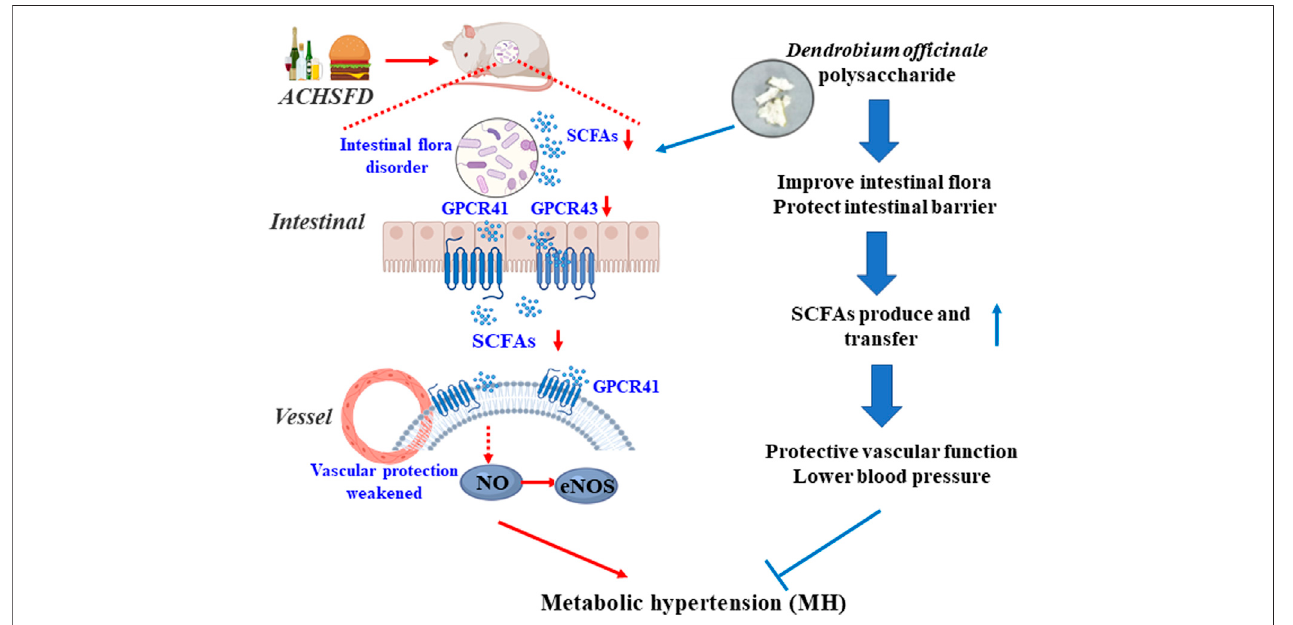
FIGURE 9 | Graphical abstract: DOPS treatment with the metabolic hypertension rats by activating the enteric-origin SCFAs-GPCR43/41 pathway.